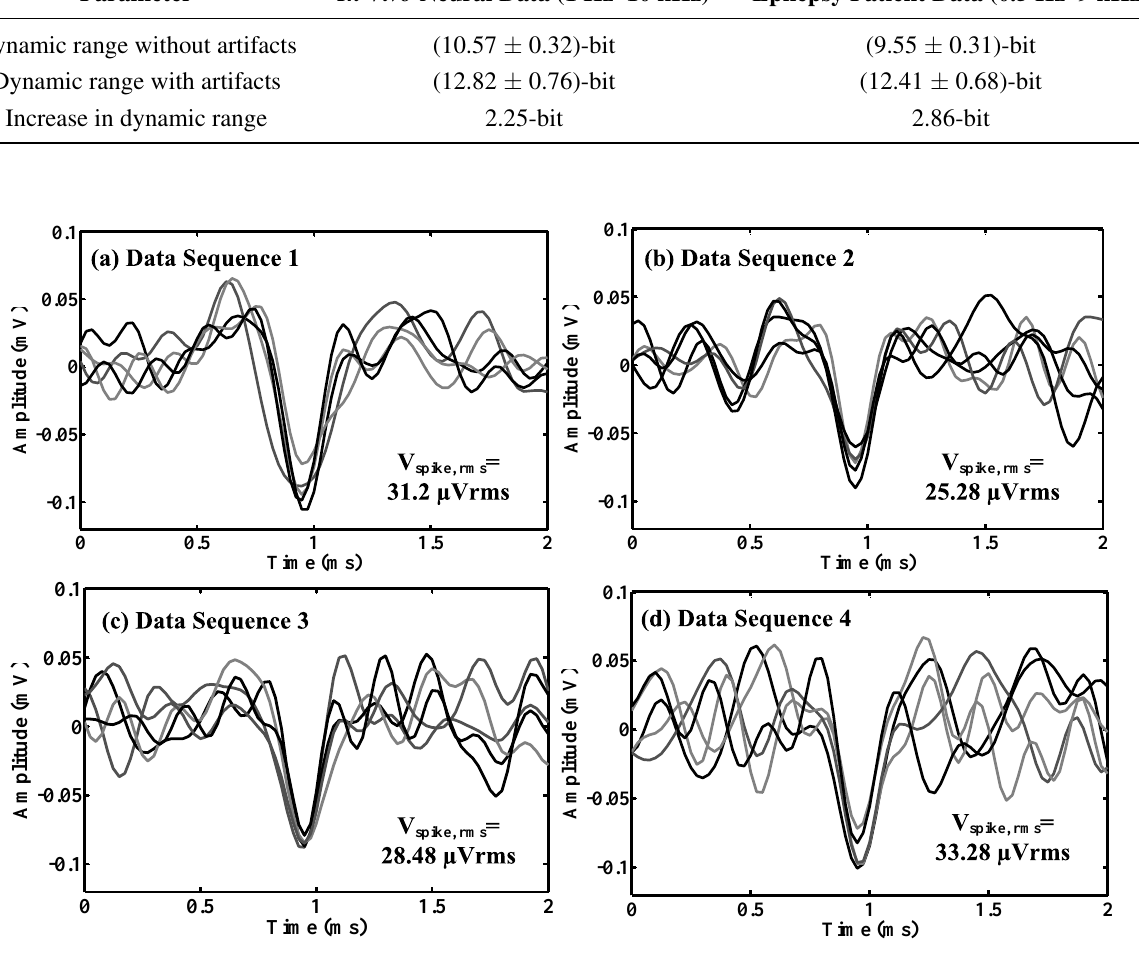
Figure 3. Exampled spike templates extracted from four in vivo data sequences ( a – d